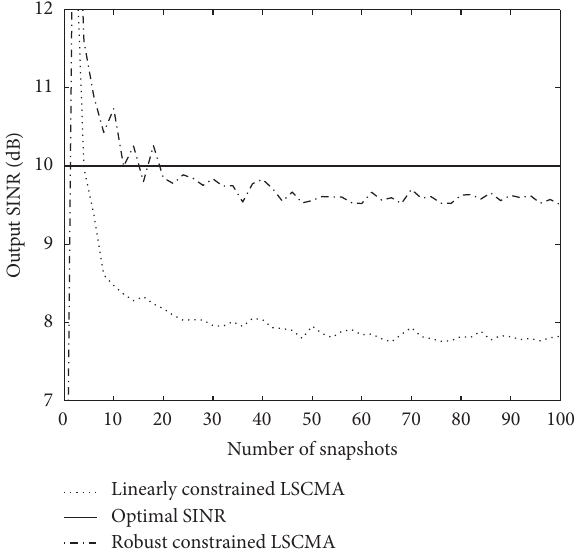
Figure 4: Output SINR versus 𝑁 (in no mismatch case).